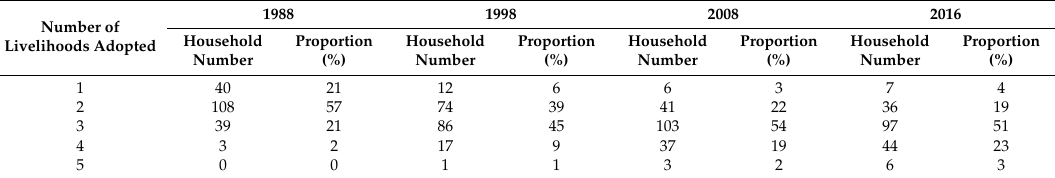
Table 5. Households relying on different number of livelihoods from 1988 to 2016.